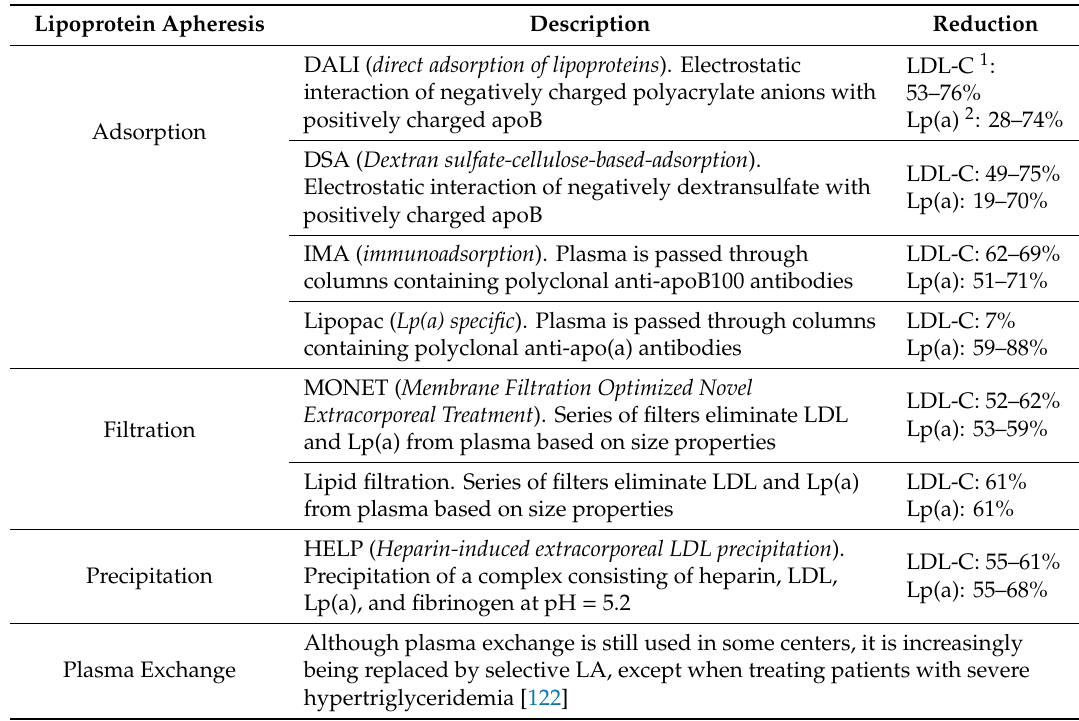
Table 3. Impact of di ff erent lipoprotein apheretic approaches on LDL-C and Lp(a)